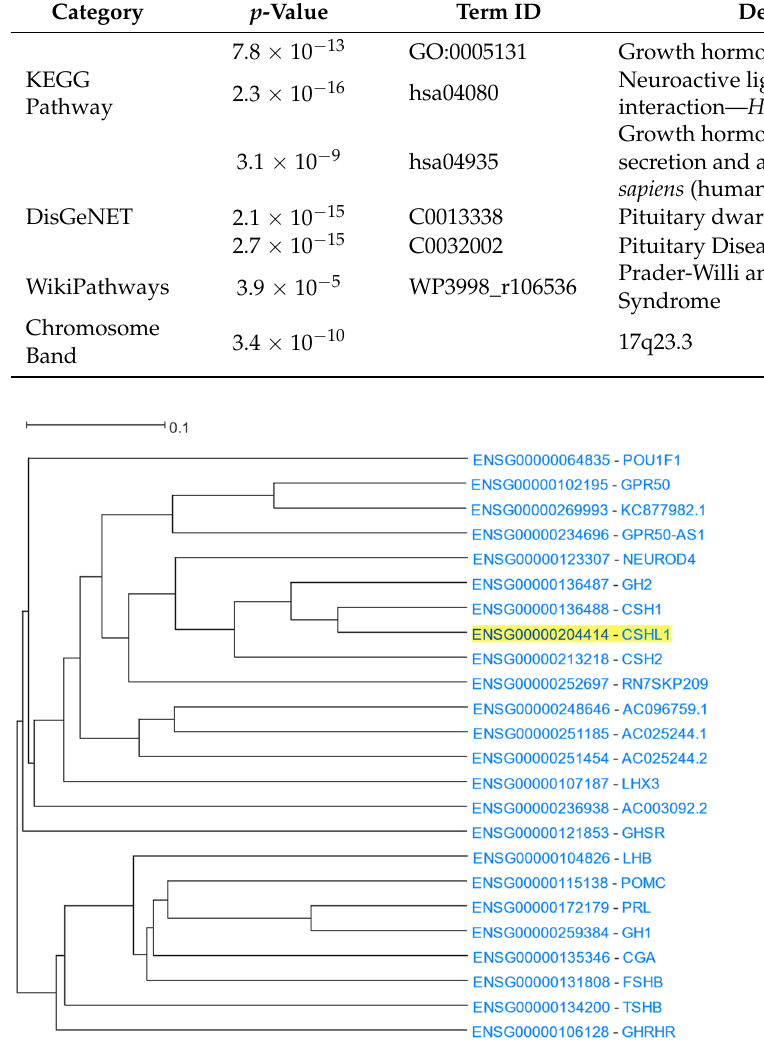
Figure 14. HGCA2.0 CSHL1 12 internal node coexpression clade.